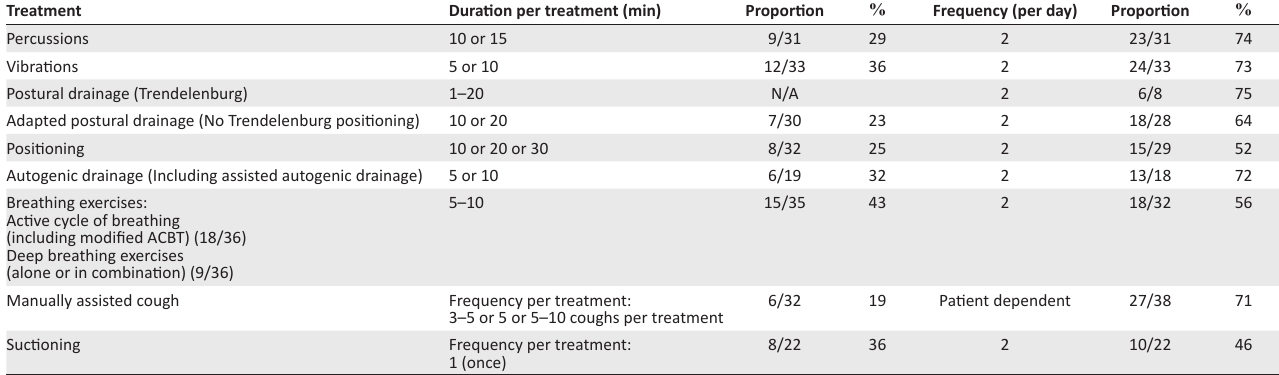
051015202530354045 FIGURE 3: Acute respiratory management in children and adolescents with neuromuscular diseases ( n = 39–44). TABLE 1: Summary of suggested treatment duration and frequencies for peripheral and proximal airway clearance techniques (acute care). Treatment Duration per treatment (min)